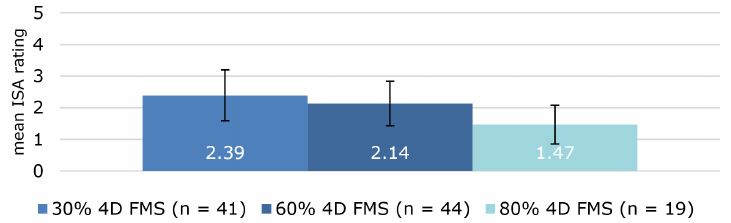
Figure 10. Mean ISA ratings in the different scenarios (S30 vs. S60 vs. S80) summarised over all participants and assessment times. Error bards represent standard